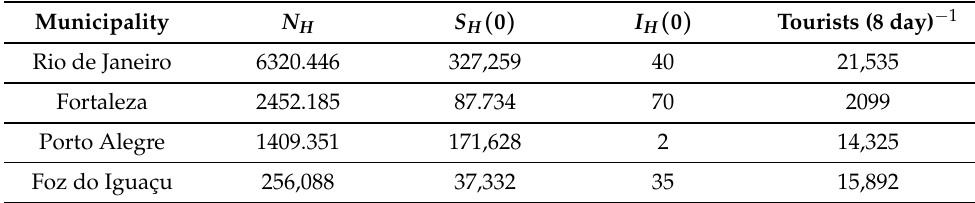
Table 3. Initial municipality-specific conditions for